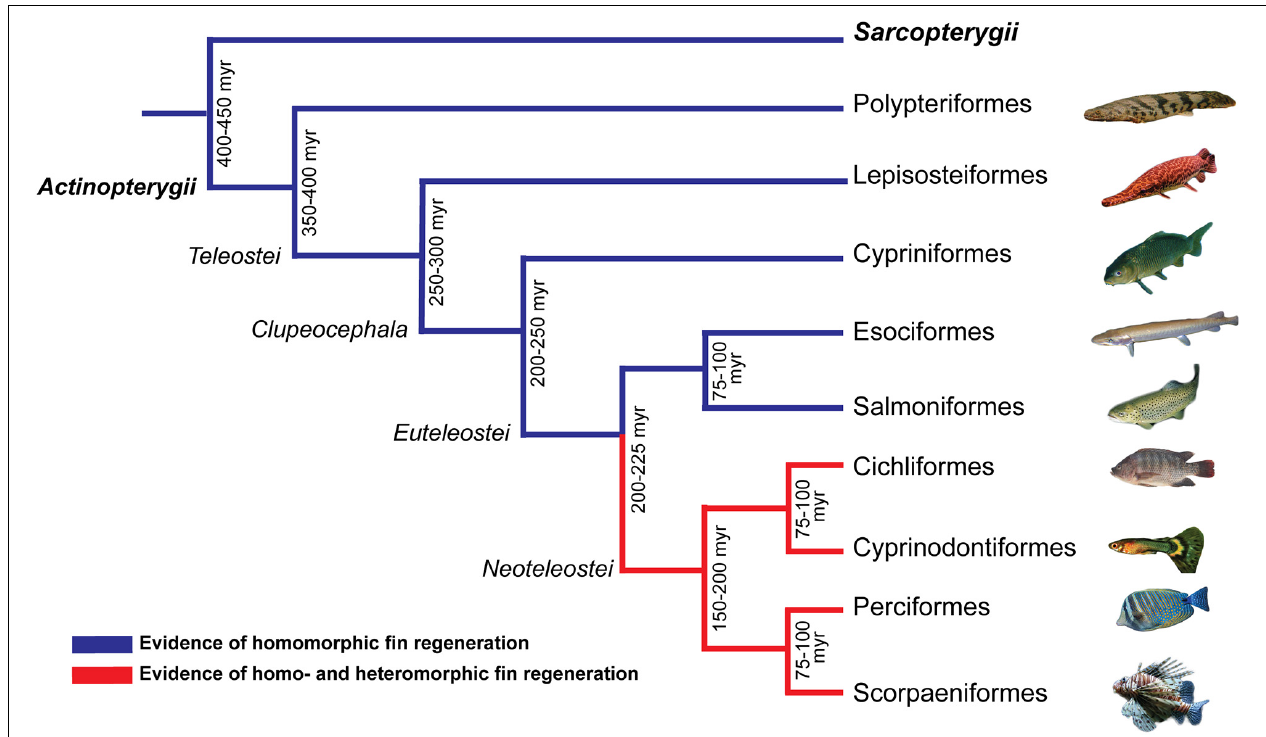
FIGURE 1 | Schematic representation of type of fin regeneration in different fish lineages. Topology of phylogenetic tree showing the distribution of homo- and heteromorphic fin regeneration in the class Sarcopterygii (lobe-finned fishes) and different orders of the class Actinopterygii (ray-finned fishes). Lineages with reports of homomorphic fin regeneration are highlighted in blue, while lineages with evidence for homo- and heteromorphic fin regeneration are highlighted in red (Wagner and Misof, 1992; Cuervo et al., 2012; Darnet et al., 2019). Numbers after nodes represent the estimated time (in millions of years, myr) since the emergence of the new